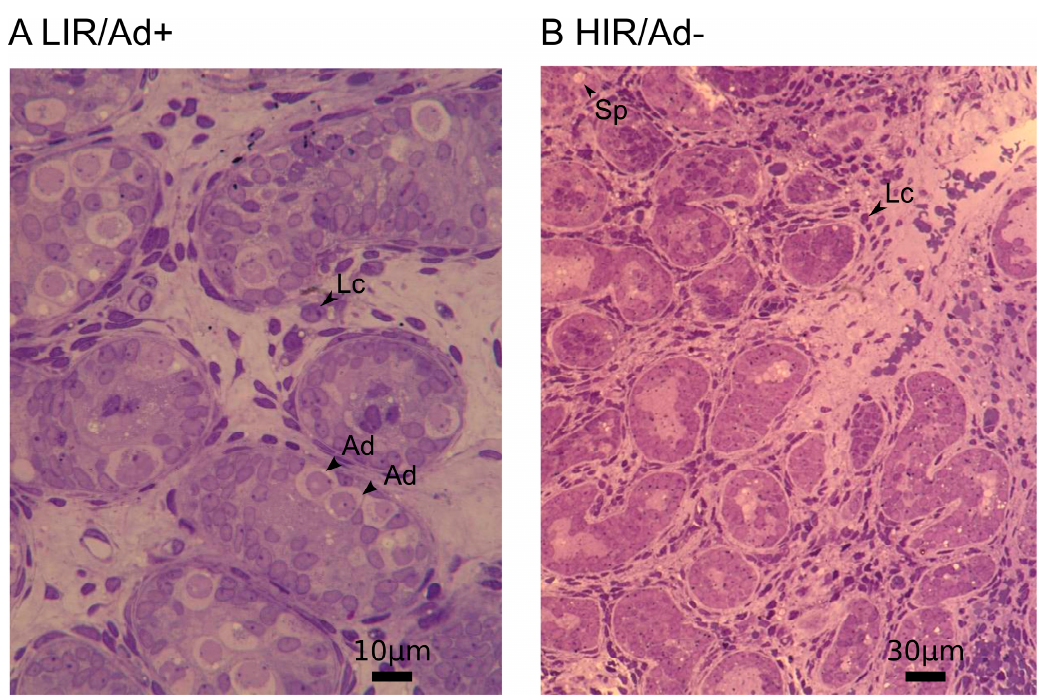
Figure 1. Semi ‐ thin sections of prepubertal cryptorchid testes. ( A ) Low infertility risk (LIR/Ad+) testes and ( B ) high infertility risk (HIR/Ad − ) testes. Atrophic Leydig cells (LC) and a severe reduction of germ cells is a typical picture in cryptorchid boys with defective mini ‐ puberty (Ad − group). Dark type (Ad) spermatogonia, juvenile LC and germ cells (Sp) are indicated with arrow heads. Cryptorchid boys, of a median age of eight years, who were treated with a gonadotropin ‐